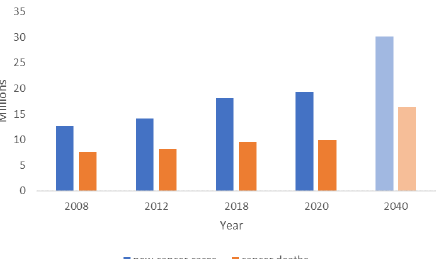
Figure 1. Estimations of new cancer cases and cancer deaths occurred in 2008 [3], 2012 [4], 2018 [5] and 2020 [6] worldwide, including a projection for 2040 (light blue—new cancer cases; light or- ange—cancer deaths) [2].